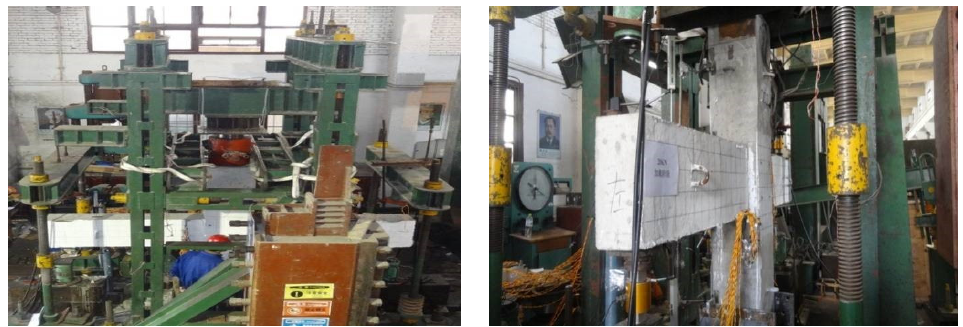
Figure 3. General view of the test setup. Appl. Sci. 2020 , 10 , x FOR PEER REVIEW